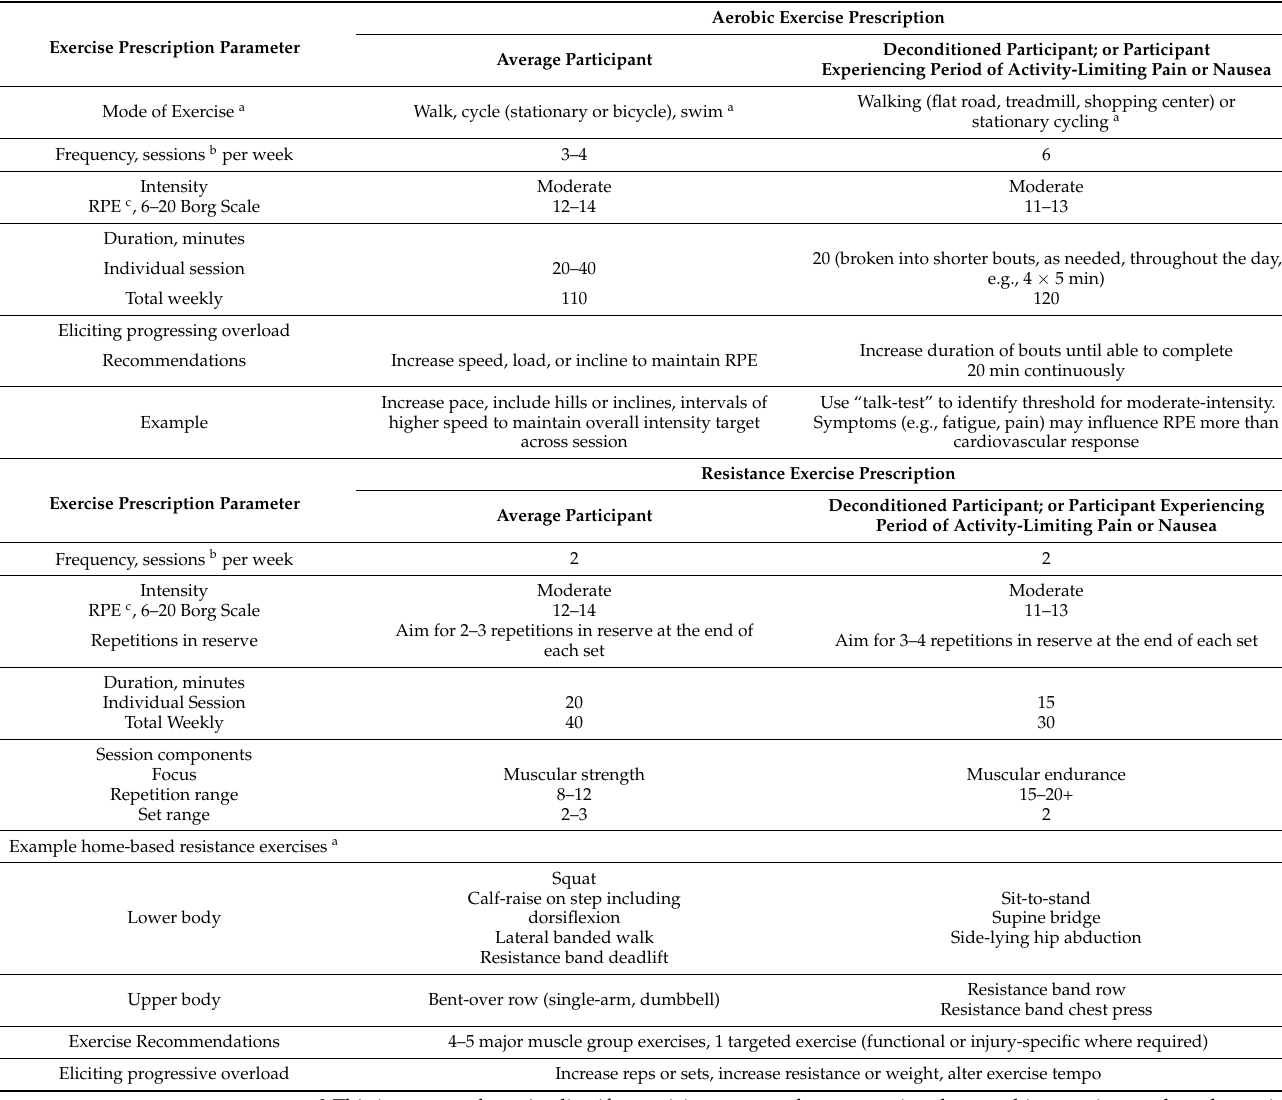
Table 2. Example exercise sessions including prescription